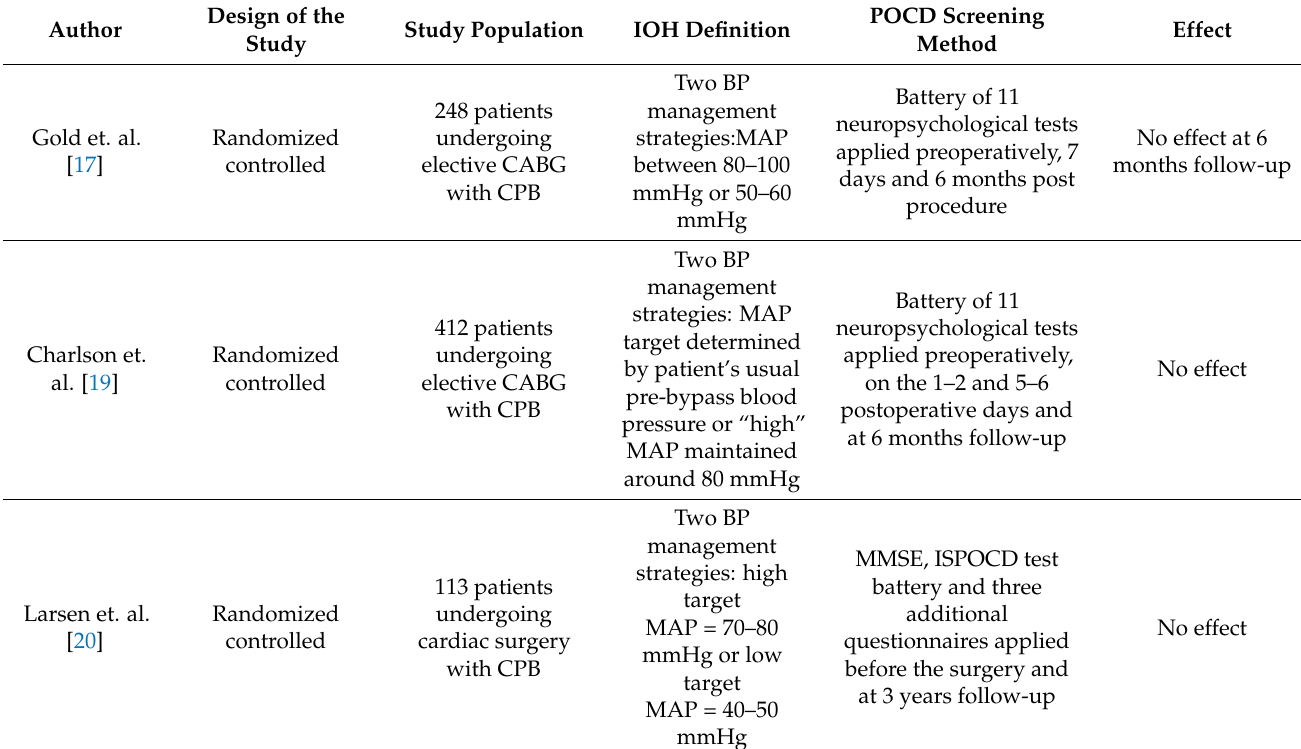
Table 1. Summary of studies on the association between intraoperative hypotension (IOH) or intraoperative blood pressure drop in cardiac surgery and postoperative cognitive decline (deficit)